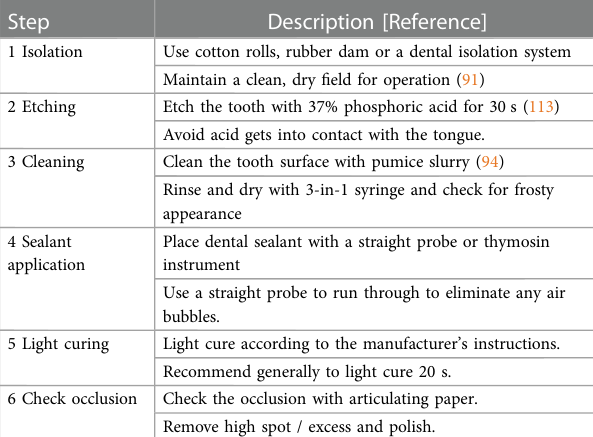
TABLE 2 Clinical protocol for placement of dental